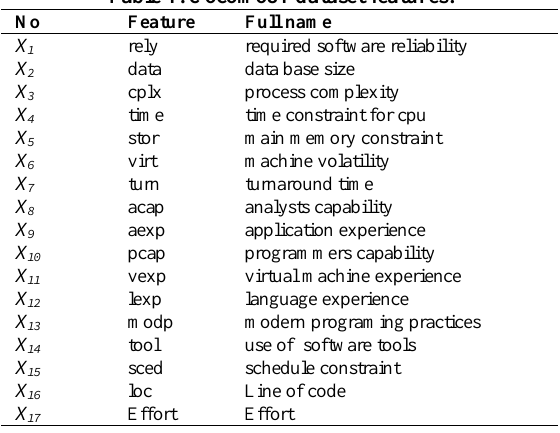
Table 2. Surplus features than cocomo81 in coconasa93.